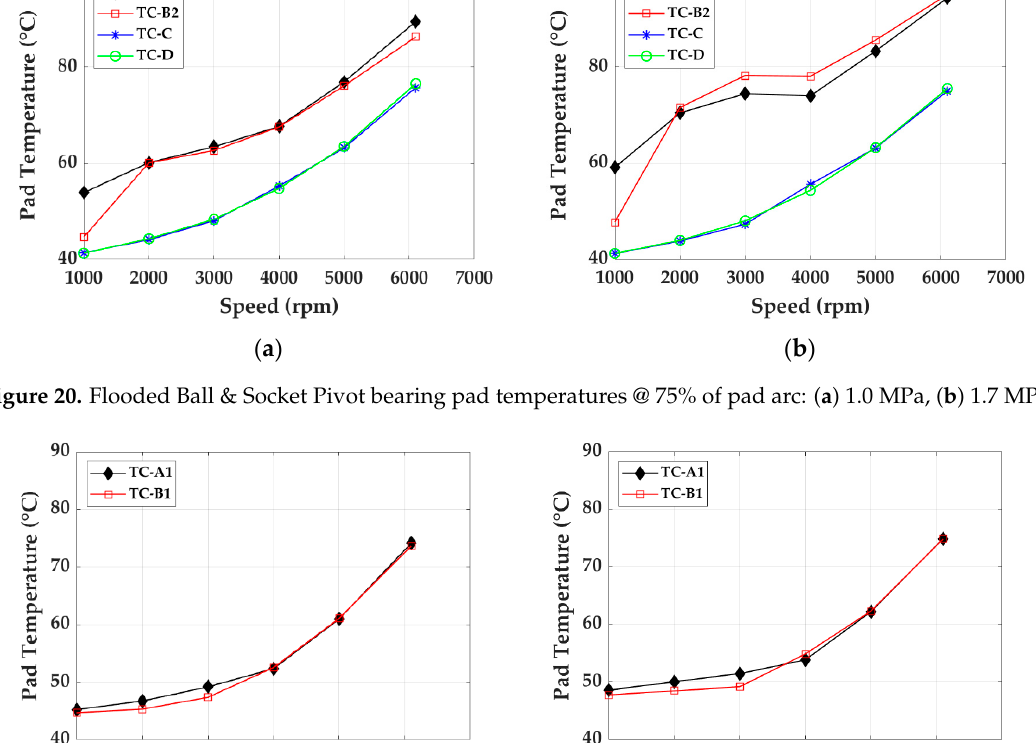
Figure 19. Flooded Rocker Pivot bearing pad temperatures @ 25% of pad arc: ( a ) 1.3 MPa, ( b ) 2.1 MPa.